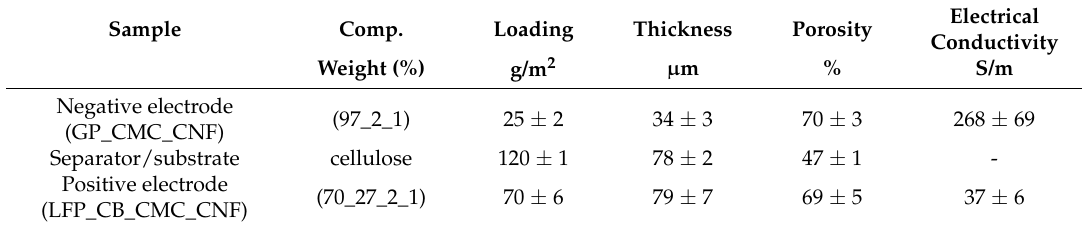
Table 1. Physical and electrical properties of the components of the reverse/side-assembled battery.